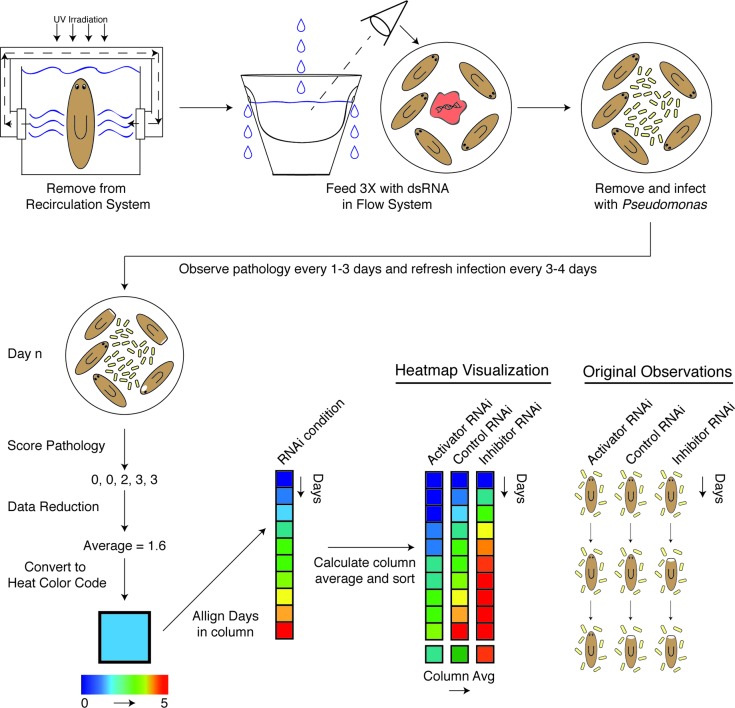
Diagram depicting workflow and data analysis of an RNAi screen to identify genes modulating pathological progression.Planaria are transferred directly from the recirculation system to a flow culture system permitting maintenance of a reduced septic state during dsRNA feedings. Following 3 RNAi feedings, planaria are removed for infection with Pseudomonas. Observations of pathological stages are recorded every 1 to 3 days, and planaria are replenished with fresh water containing Pseudomonas every 3 to 4 days. Following enumeration of pathological stages, data for each day is reduced to an average pathological score and converted to a heat color code. Days for each RNAi condition are aligned in ascending order along the y-axis of a column. The average score of each column is calculated and used to sort the effects of RNAi conditions in ascending order along the x-axis. The result is a heat map visualization ranking the effects of RNAi treatments on the pathological progression in response to bacterial infection in planarians over time.